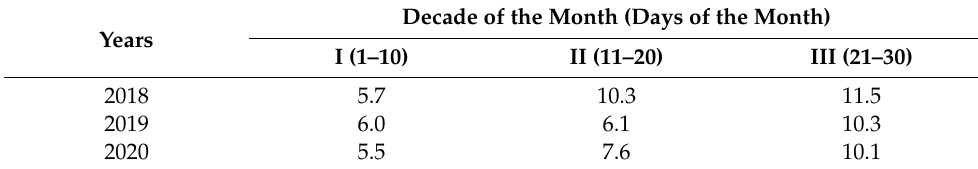
Table 1. The soil temperature ( ◦ C) in April at a depth of 3.5